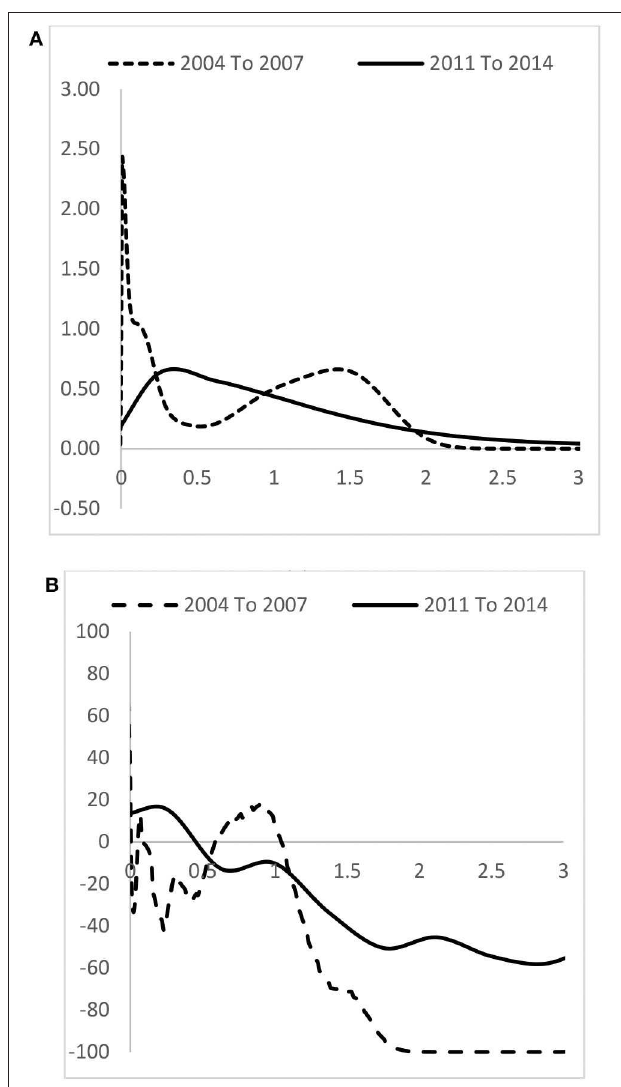
FIGURE 8 | Comparison of the ergodic distributions and MPPs of the gas market for all countries across time. Note: For (A) , horizontal axis represents relative per capita consumption, vertical axis represents proportion. For (B) , horizontal axis represents relative per capita consumption, vertical axis represents MPP. Source: Authors’